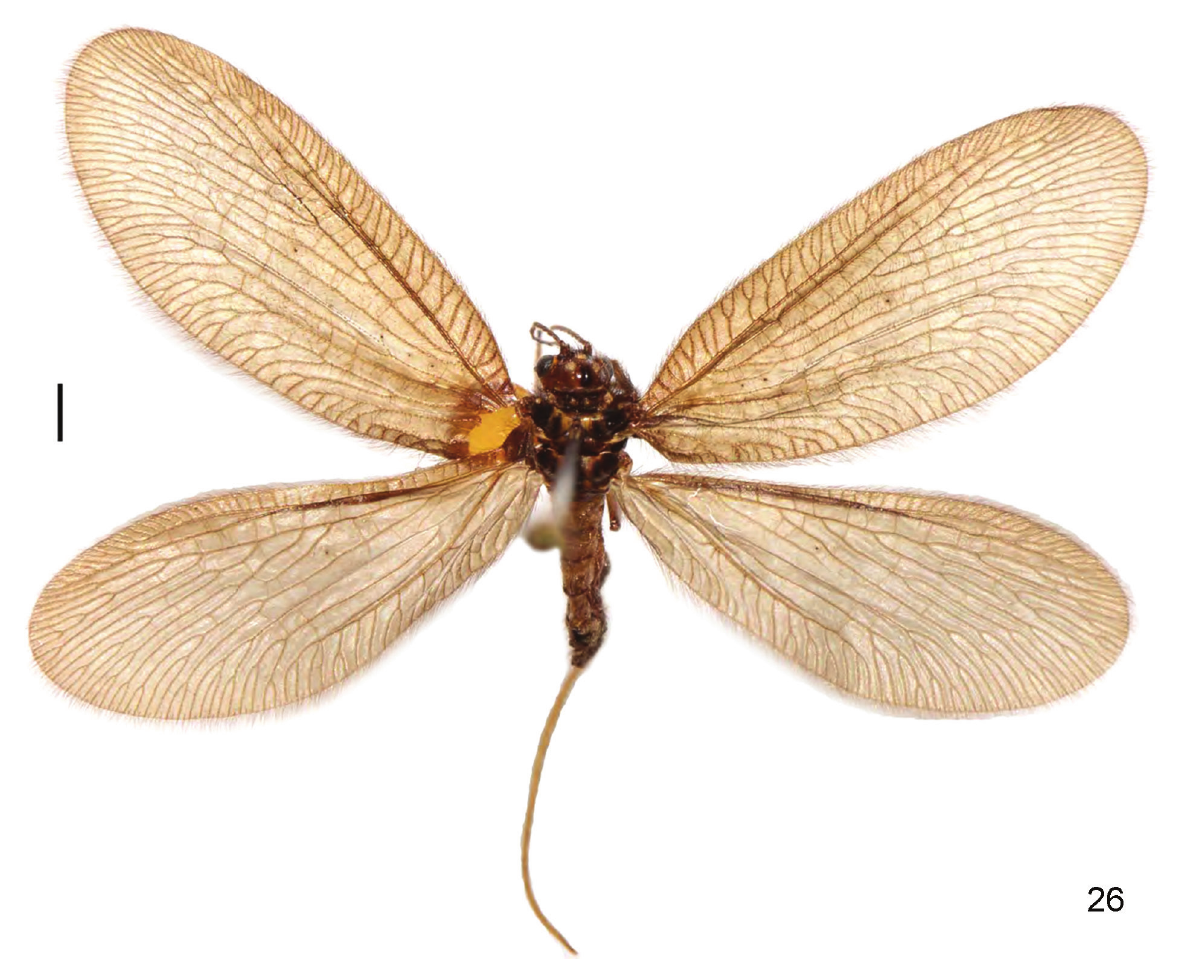
Figure 26. Dilar fuscus sp. n., holotype, female (HUAC, Vienna), habitus. Scale bar = 1.0